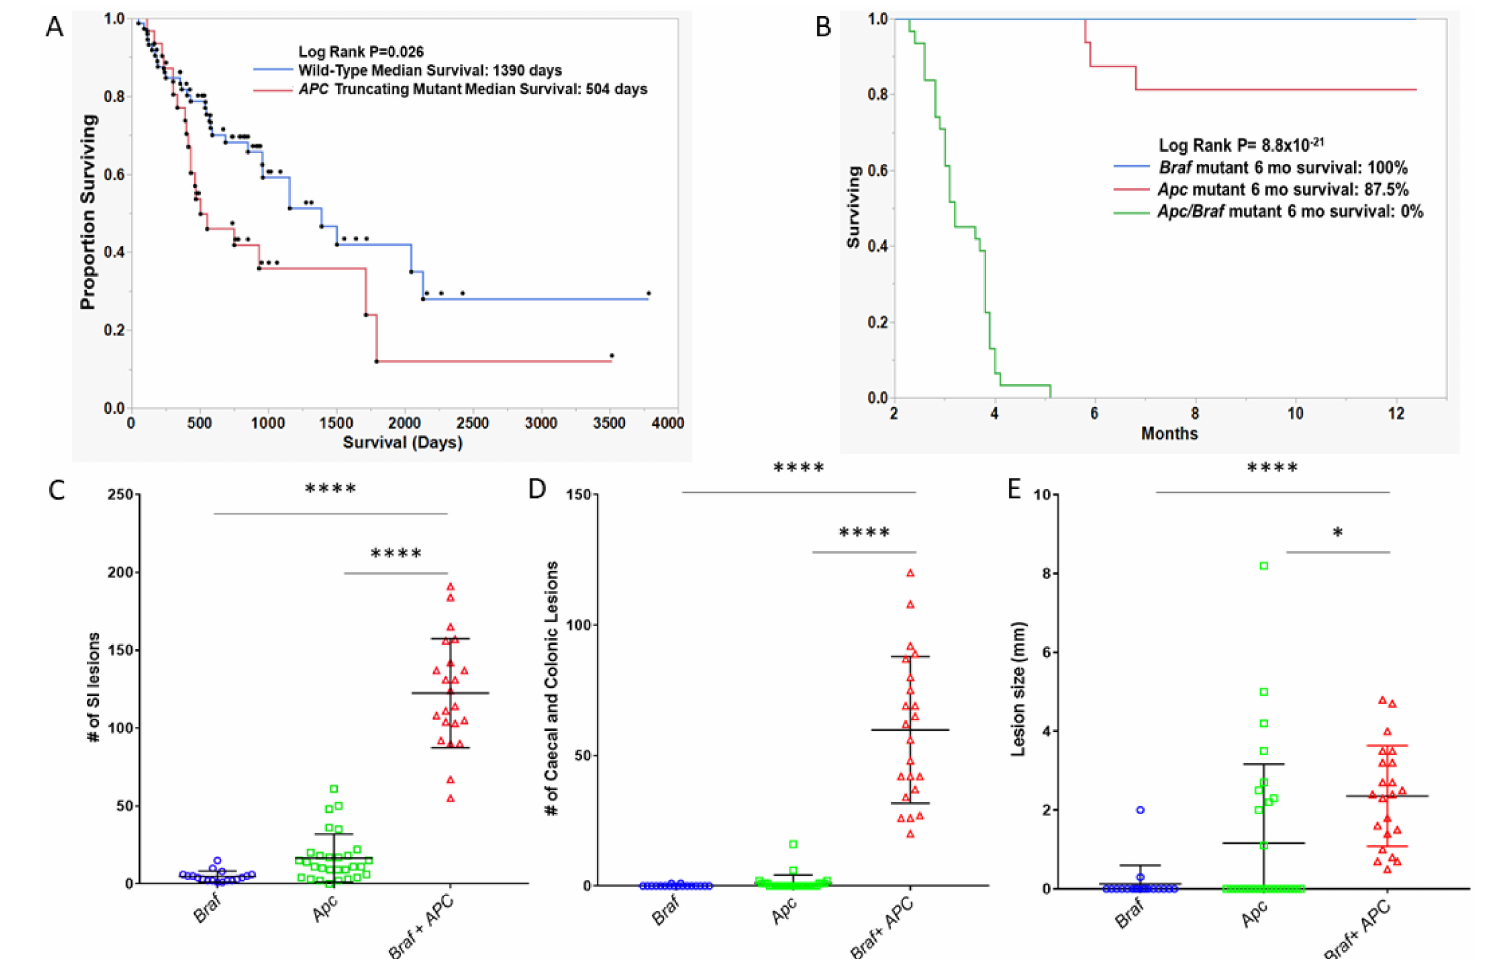
Figure 6. Survival analysis of ( A ) BRAF mutant human cancers by the presence or absence of truncating APC mutation. ( B ) Apc , Braf , and Apc / Braf mutant murine models. p -values are univariate and derived from the log-rank test. ( C – E ) Assessment of the number and size of lesions in Apc , Braf , and Apc / Braf mutant mouse models. ( C ) Total lesions in the small intestine. ( D ) Total number of lesions in the colon and caecum. E: Mean size of lesions in the colon and